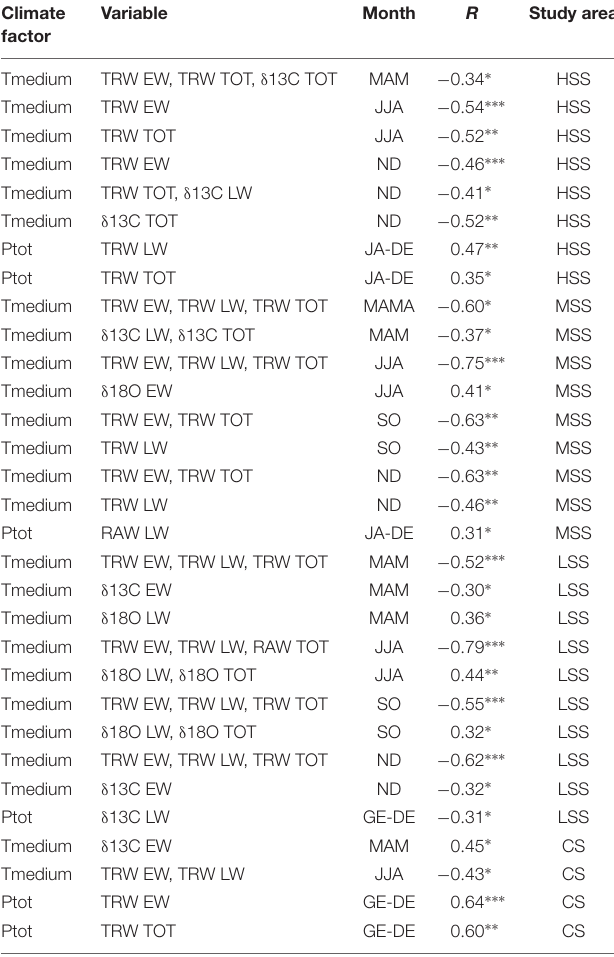
R indicates the correlation coefficient of Pearson, with the corresponding significance ( ∗ P < 0.05, ∗∗ P < 0.01; ∗∗∗ P < 0.001) calculated according to Student’s